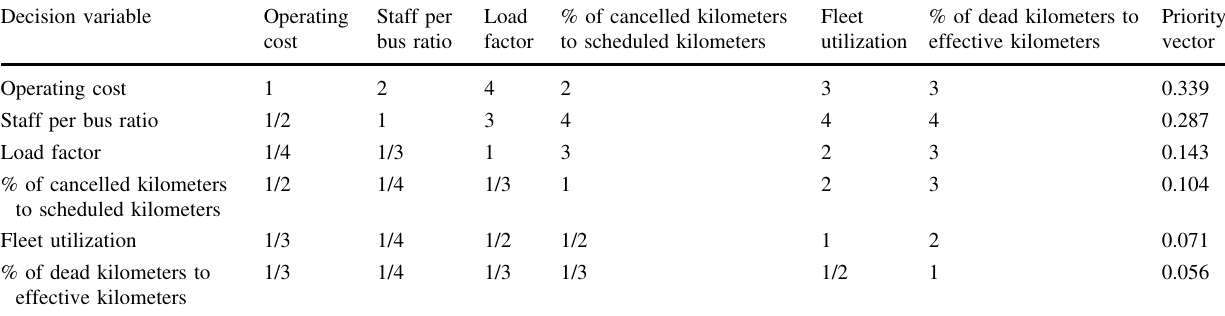
Table 4 Pairwise comparison matrix of operator-oriented decision variables Decision